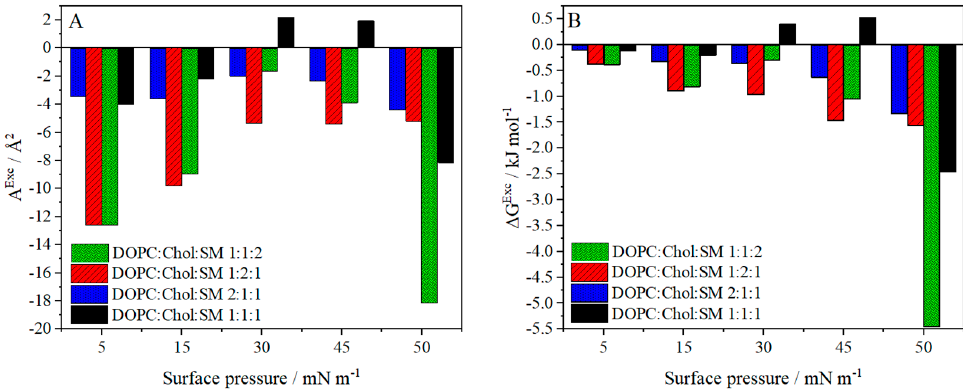
Figure 4. Values of ( A ) the excess area ( ∆ A Exc ) and ( B ) the excess free energy ( ∆ G Exc ) calculated at selected surface pressures for DOPC:Chol:SM 1:1:2 (green), DOPC:Chol:SM 1:2:1 (red), DOPC:Chol:SM 2:1:1 (blue) and DOPC:Chol:SM 1:1:1 (black) monolayers.